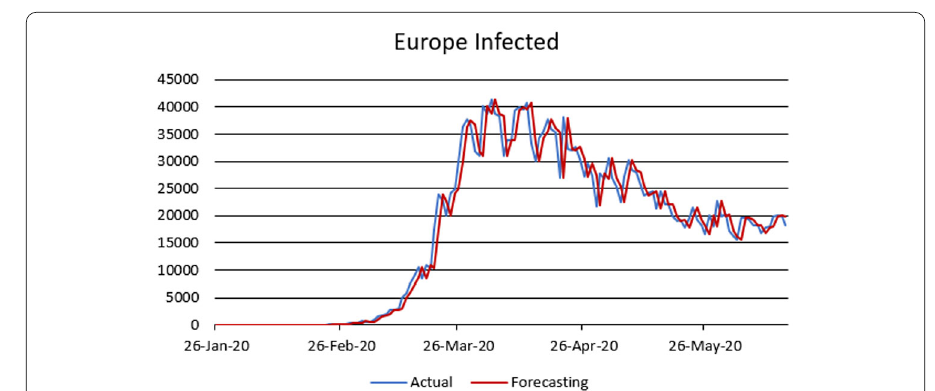
Figure 9 Exponential smoothing for the infected in Europe